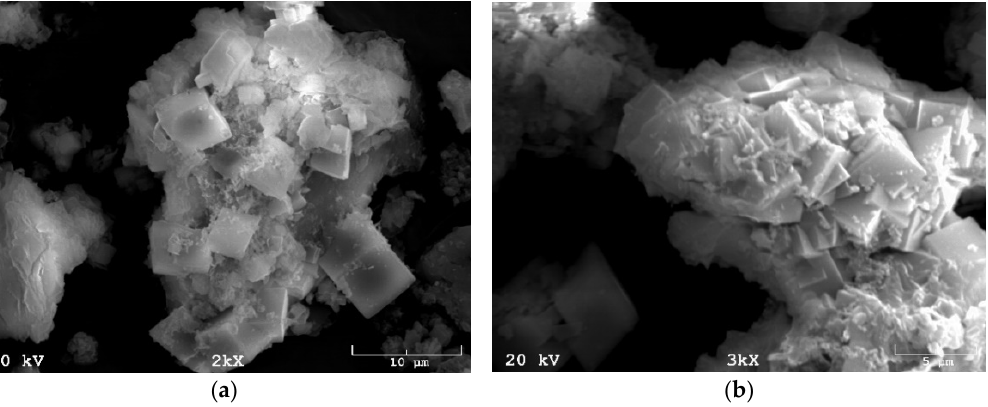
Figure 10. Morphology of the zeolite fractions obtained from the coal shale synthesis process: ( a ) at 2000× magnification; ( b ) at a magnification of 3000×.